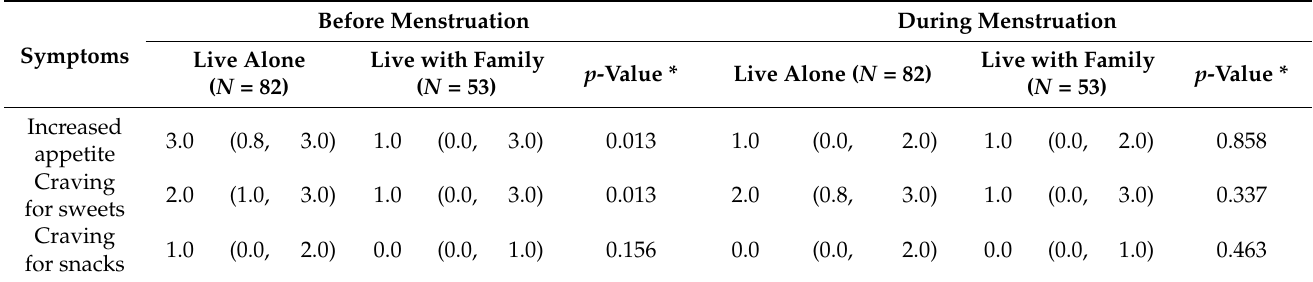
Table 5. Intensities of eating symptoms depending on living